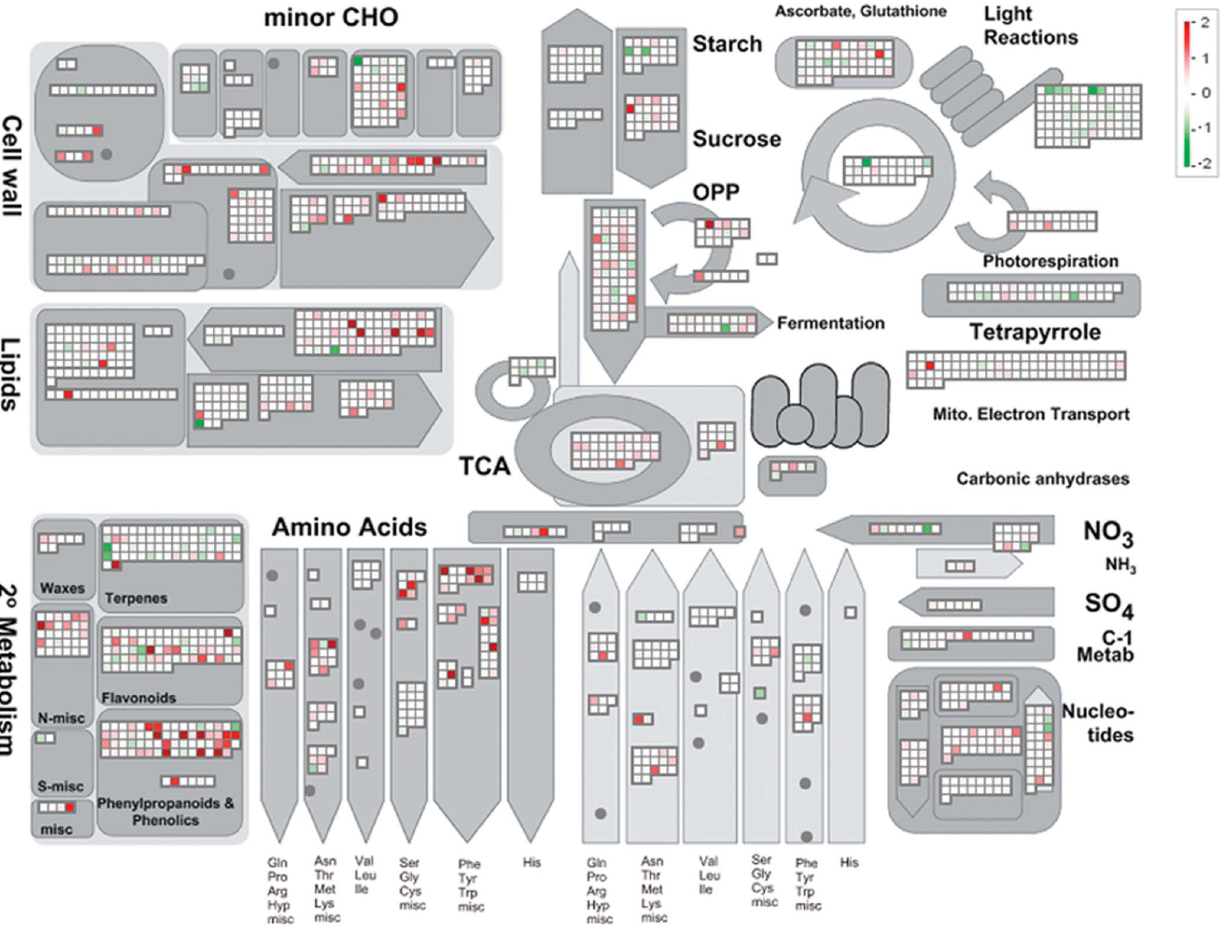
Figure 3. Overview of the transcriptional changes in IRBL18 at 24 hours post-inoculation. Genes significantly up- (red) or down-regulated (green) in fungal-inoculated leaf samples relative to mock-inoculated are illustrated. The scale bar displays log2-transformed fold changes.